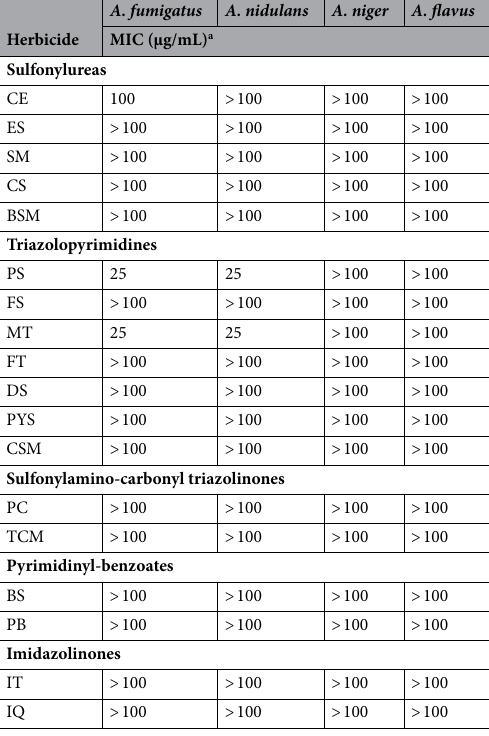
Table 2. MIC values of herbicides for A. fumigatus , A. nidulans , A. niger and A. flavus cells. a MIC indicates concentration of herbicides in wells with no observable Aspergillus growth.